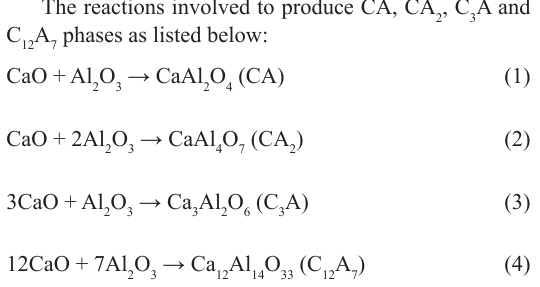
Table 1. Processing conditions for the production of calcium aluminate cement phases based on Al solid content in the suspension. CAC phase